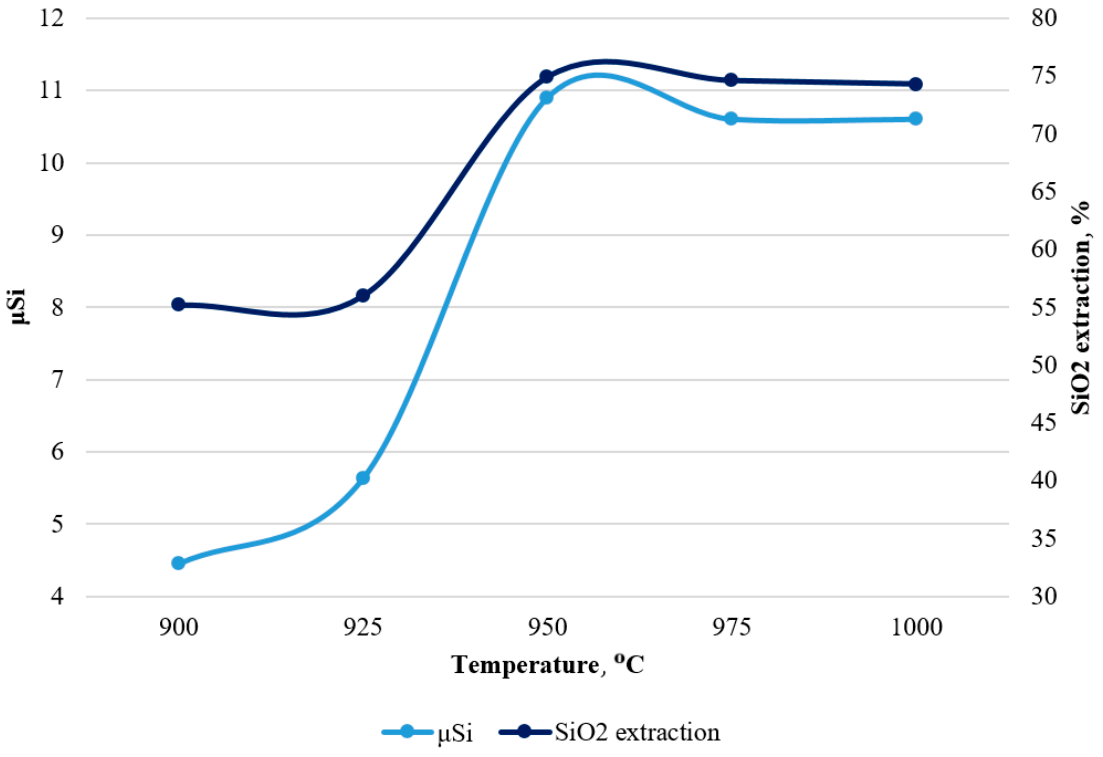
Figure 10. Changes in the silicon modulus ( µ Si ) of bauxite and the extraction degree of SiO 2 (legend right) into solution as a result of chemical beneficiation.